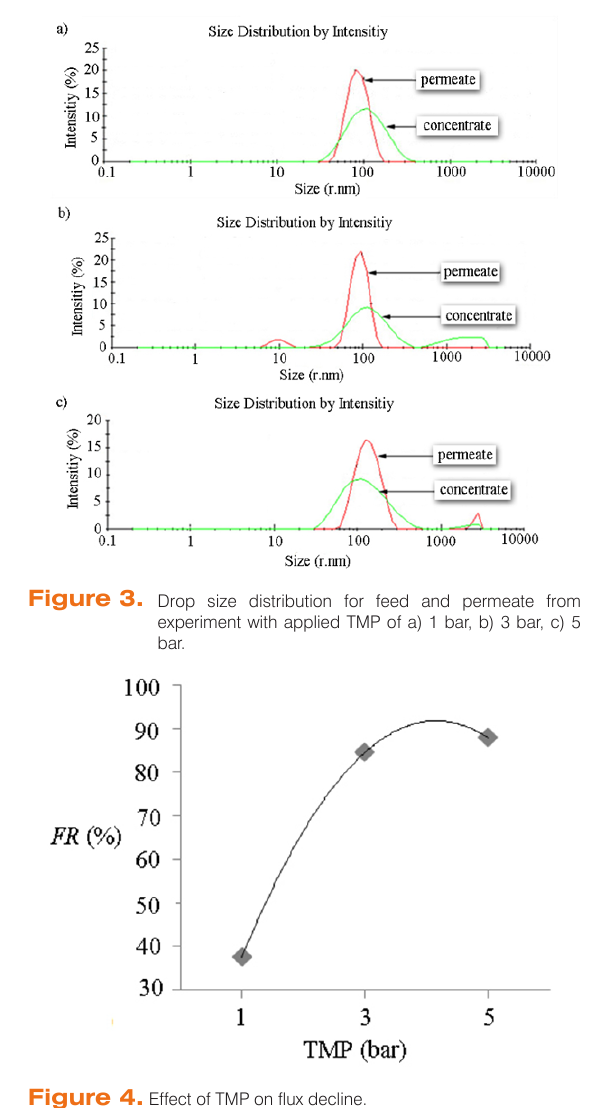
Figure 4. Effect of TMP on flux